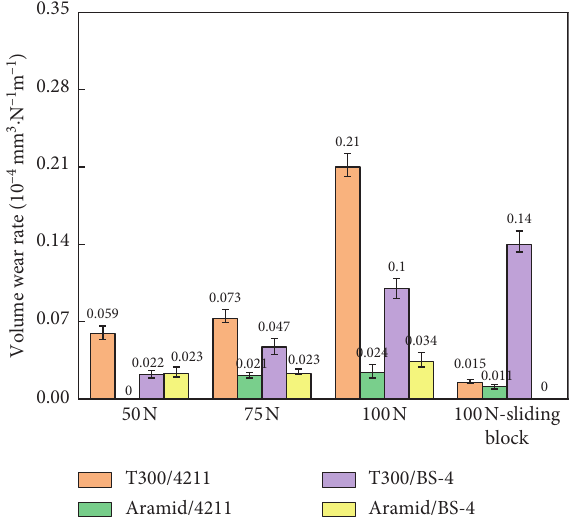
Figure 8: Wear rate of composites paired with brass pins and sliding blocks under different